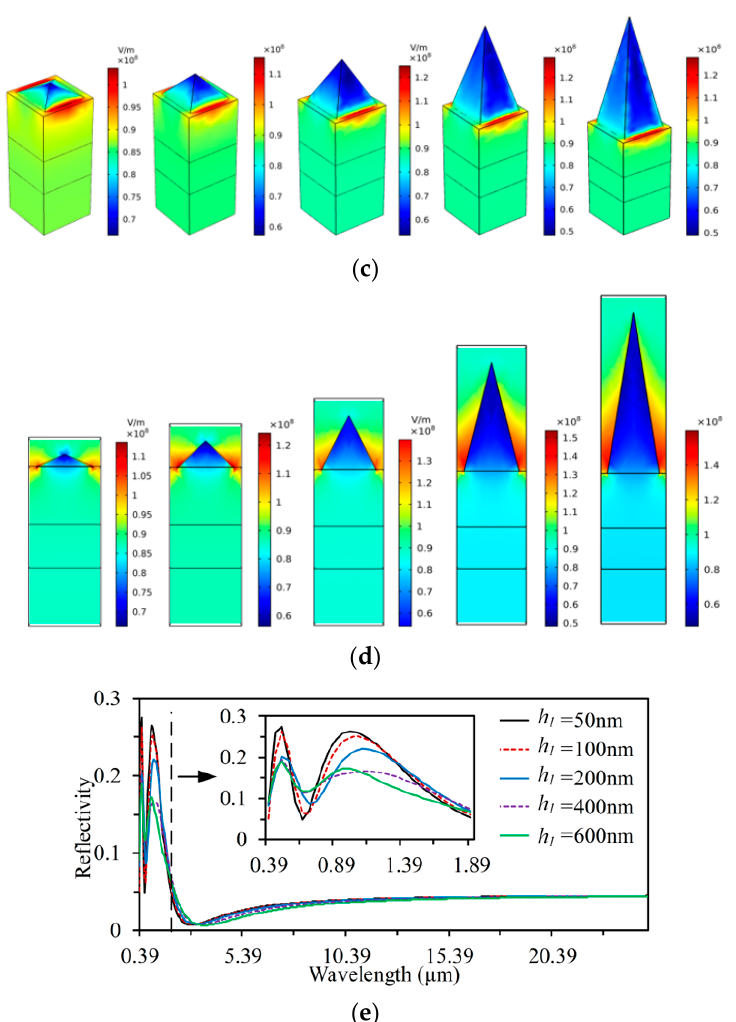
Figure 2. Numerical results of spectral characteristics of pyramidal biomimetic micro-nano structures as a function of tip height. Images of three ‐ dimensional and central cross ‐ sectional distribu ‐ tions of the electrical field intensity for the pyramidal micro ‐ nano structures with a variety of tip heights (50, 100, 200, 400 and 600 nm) under the wavelength of 0.99 μ m ( a , b ) and 9.99 μ m ( c , d ), respectively. ( e ) Spectral reflectance curves of pyramidal biomimetic micro-nano structures modulated by tip height indicate that a decrease in tip height can decrease the solar absorptance and the infrared emissivity.